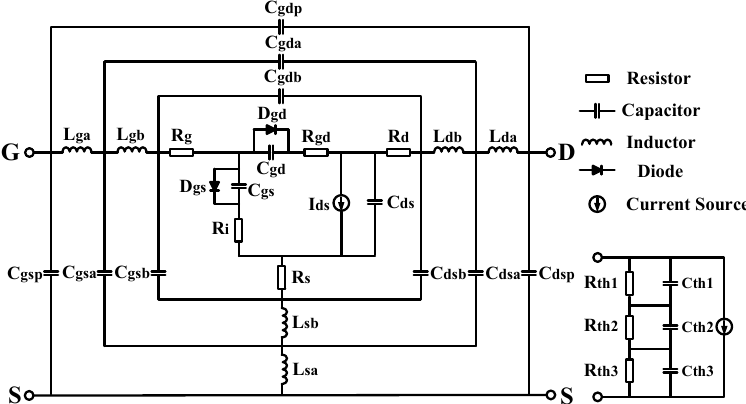
Figure 5. Topology of Large signal model up to W band.